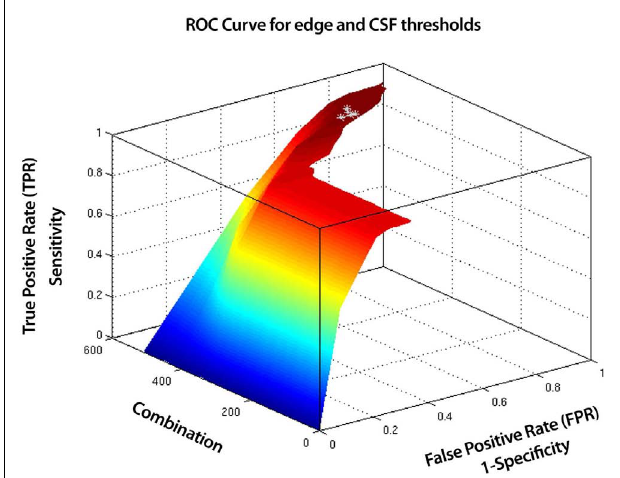
FIGUREA1 | Receiver Operating Characteristic (ROC) curve for edge and CSF thresholds for 5 test subjects . A total of 525 combinations of edge and CSF thresholds (ranging from 0 to 70%) were tested. Shown in light gray are combinations where the classification in the 5 subjects did not change significantly (within 10%).These represent the ranges, 40–50% for the edge threshold and 20–30% for the CSF threshold. Lower values resulted in at least one neuronal component being misclassified as artifact (i.e., having a sensitivity of less than one which we regard as failure), whilst higher values resulted in fewer artifacts being identified (which we regard as a decrease in performance or smaller specificity).To minimize the chance of failure we chose the highest thresholds before a decrease in performance occurs (i.e., well away from the failure condition); 50 and 30% for the edge and CSF thresholds respectively.